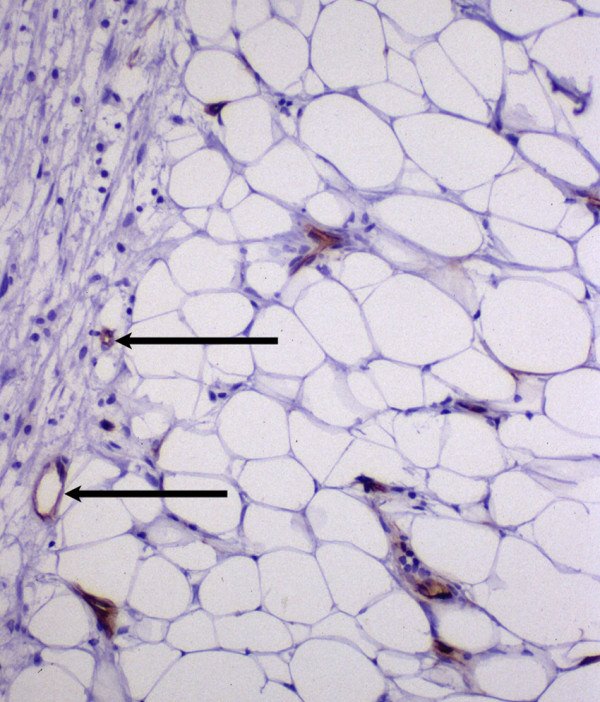
Average microvessel count – VEGF. Ten high power (200×) fields along the border between cancer nests and the stroma were evaluated for each section. The average number of microvessels (arrows) per high power field was determined and reported as AMC.